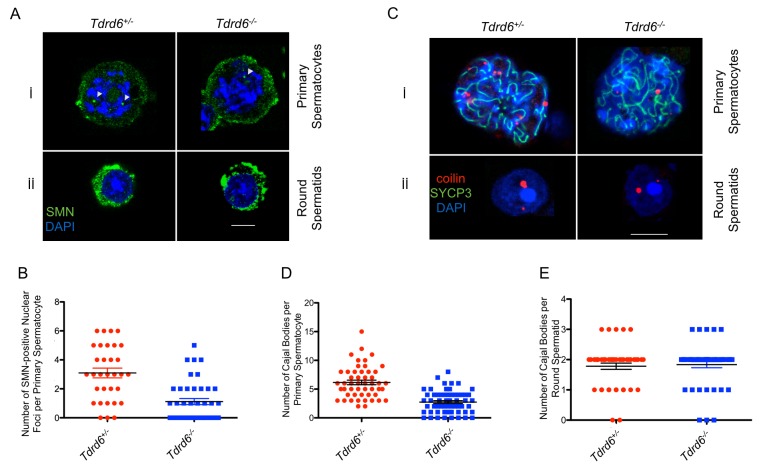
Numbers of SMN-positive nuclear bodies and Cajal bodies (CBs) are diminished upon TDRD6 deficiency.(A) Immunofluorescence staining of MACS-isolated hCD4+ cells from the testes of Tdrd6+/- and Tdrd6-/- littermates with α-SMN (green) and DAPI (blue). Cells at different stages of spermatogenesis are indicated. Scale bar: 5μm (B) Quantification of the number of SMN-positive nuclear bodies in primary spermatocytes is presented in a scatter plot. The number of SMN-positive nuclear bodies is reduced by circa 70% upon TDRD6 loss (P < 0.0001). (n = 32 for Tdrd6+/-, n = 42 for Tdrd6-/- derived from 3 different biological replicates) (C) Immunofluorescence staining of MACS-isolated hCD4+ cells from the testes of Tdrd6+/- and Tdrd6-/- littermates with α-coilin (red) and α-SYCP3 IgG (green) and DAPI (blue). Cells at different stages of spermatogenesis are indicated. Scale bar: 5μm (D) Quantification of the number of CBs in primary spermatocytes based on the coilin staining in (C) is presented in a scatter plot. The number of CBs is reduced by 50% upon TDRD6 loss (P < 0.0001). (n = 50 for Tdrd6+/-, n = 59 for Tdrd6-/- derived from 4 different biological replicates) (E) Quantification of the number of CBs in round spermatids based on the coilin staining in (C) is presented in a scatter plot. The number of CBs did not change upon TDRD6 loss (P = 0.7245). (n = 46 for Tdrd6+/-, n = 48 for Tdrd6-/- from 4 biological replicates)